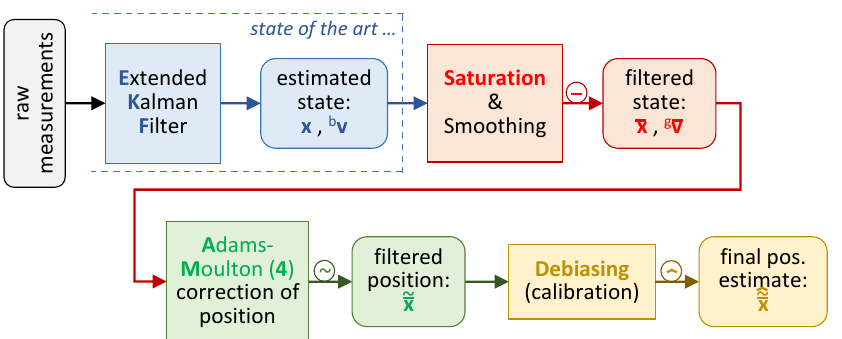
Figure A3. Proposed filtering process, consisting of four steps and returning estimates identified with their respective filter symbols: ¯ x stands for saturated, ˜ x for dynamically corrected, and ˆ x for debiased. Superscripts b and g refer to the body frame and inertial frame,